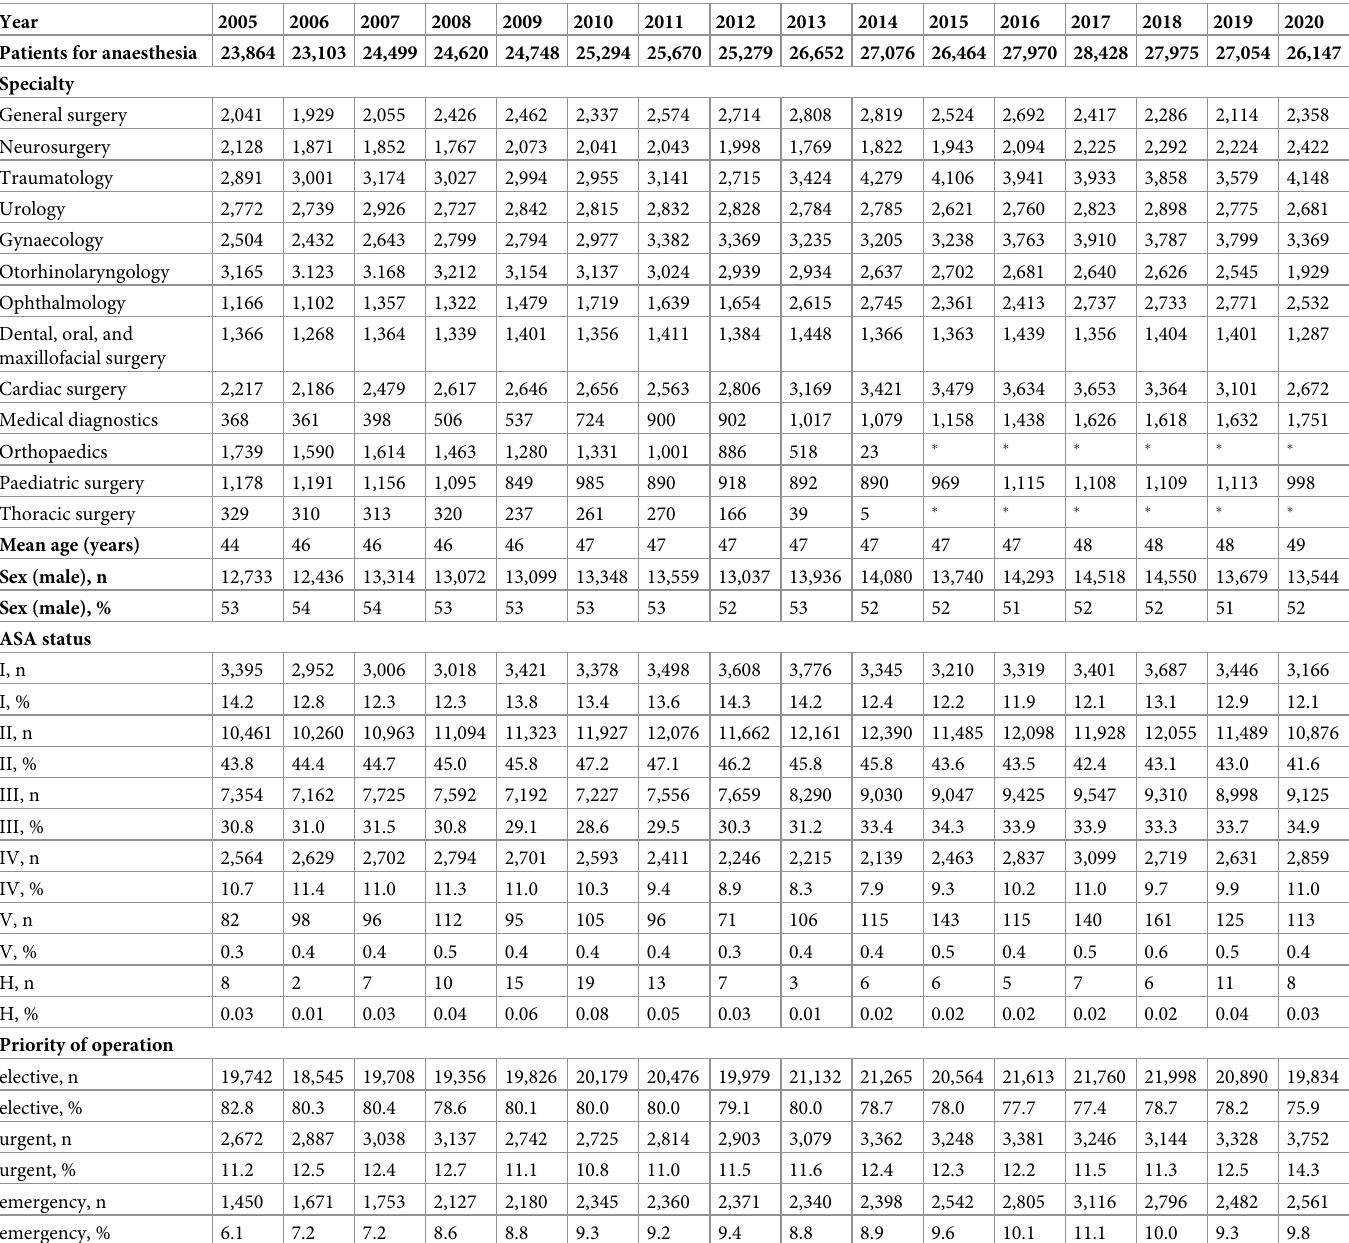
Table 1. Characteristics of patients for anaesthesia at a tertiary university hospital in Germany between 2005 and 2020 by medical/operative subspecialty, age, sex, ASA status, and priority of operation. Values are represented as means and relative proportion (%).